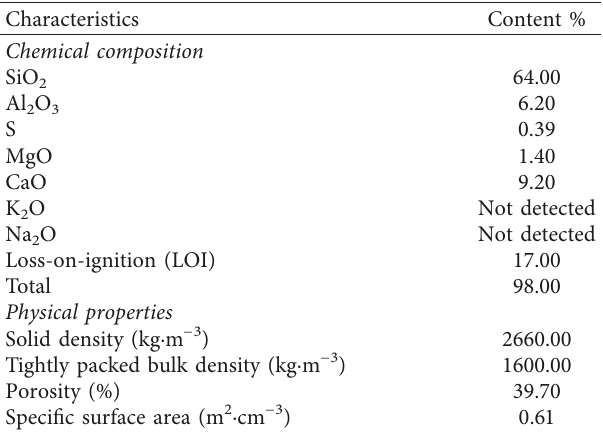
Figure 1: Particle size distribution of the tailings used in the experiments. Table 1: Physicochemical characterization of the